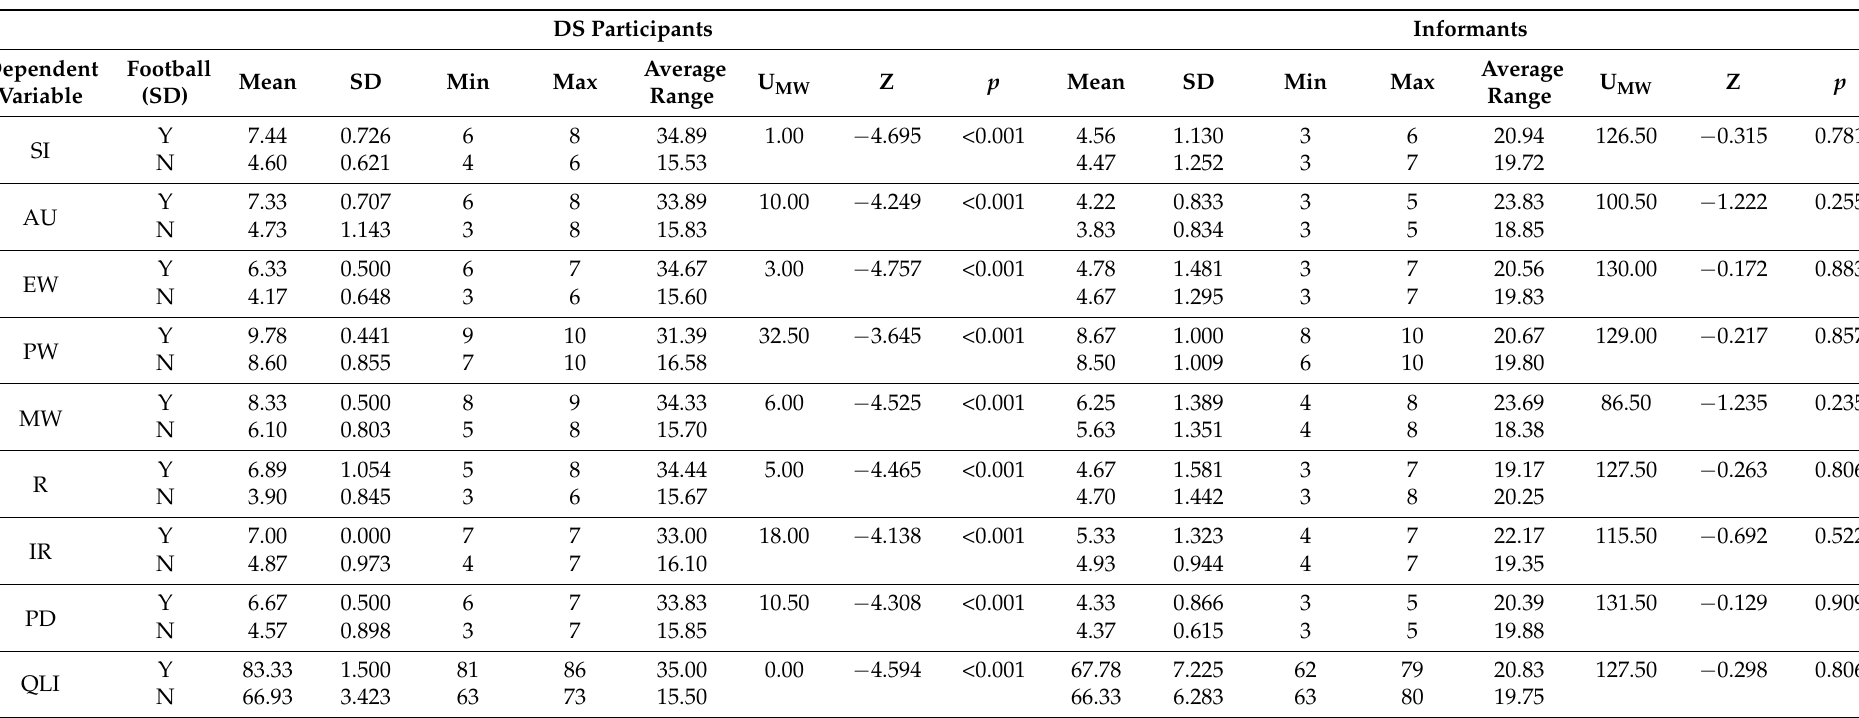
Table 5. Mann–Whitney U -tests for dependent variables with respect to practicing competitive football on the part of participants with DS (Yes, n = 9; No, n = 30) according to the opinions of the subgroup with DS and informant perceptions ( n =